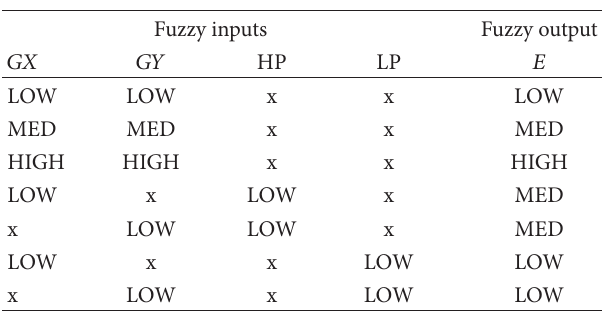
Table 1: The fuzzy rules.